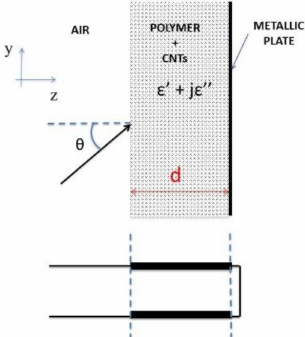
Figure 1. One-layer backed by a metallic plate (top) and transmission line model (bottom).